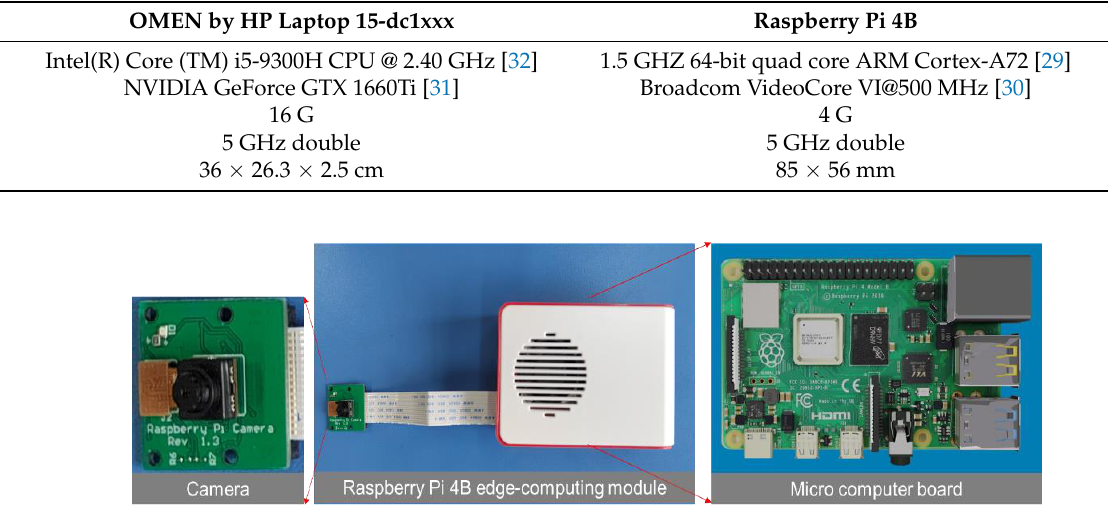
Figure 3. Image of the Raspberry Pi 4B device used for edge computing.